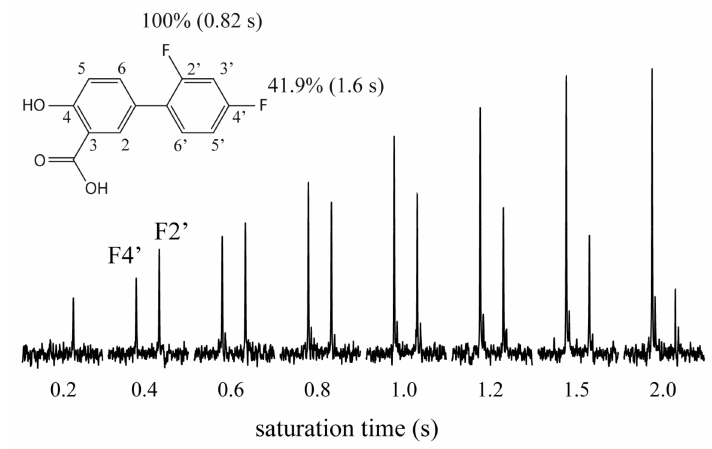
Figure 3. The 19 F{ 1 H} STD spectra acquired with the arrayed saturation times. The normalized values of the STD effect (%) and the values of 19 F- T 1 (s) are